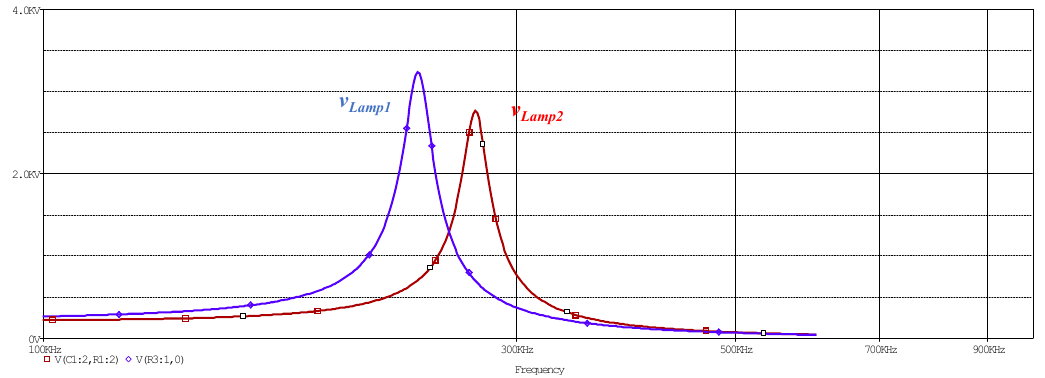
Figure 10. Management of ballast operating modes from the PIC18F2220 microcontroller. Figure 11. RI output voltage during the start-up of the EFL lamp: v lamp1 , considering only a resistive load and v lamp2 , considering the LR model (Inductance-resistance) of the lamp.